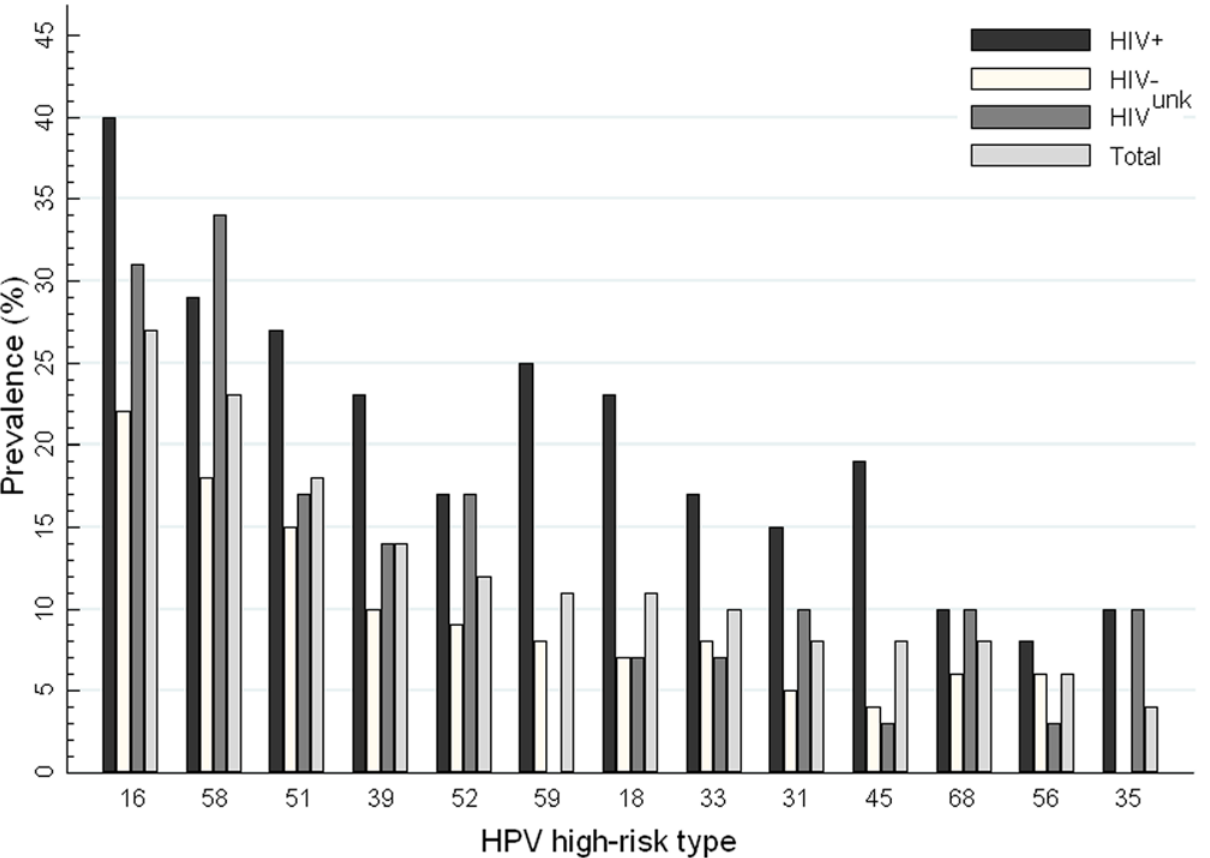
Fig 1. Prevalence of high-risk HPV types, by HIV status, ranked from left to right by decreasing percentage among total participants.